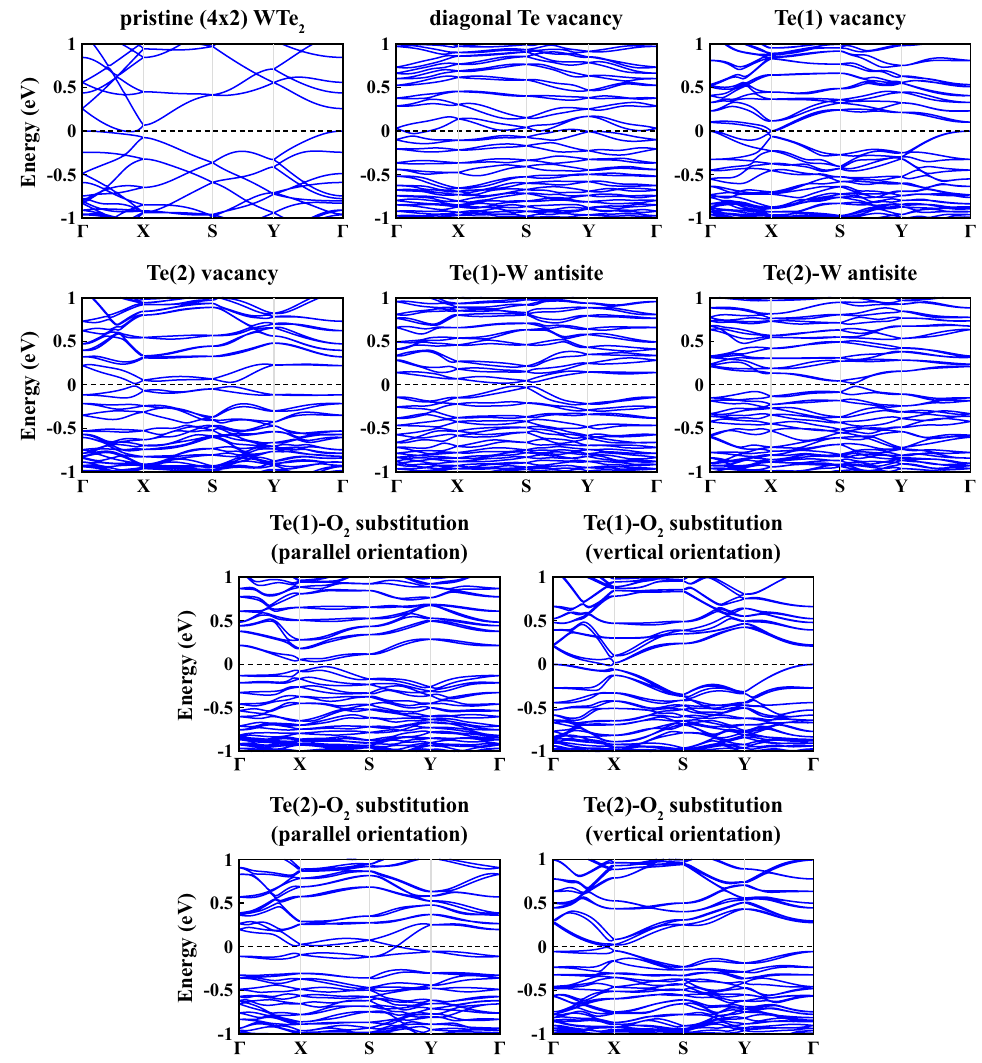
Figure 7. Electronic energy band structures, E n ( k ) , of defective 1 T ′ WTe 2 monolayer calculated within PBE+SOC along major symmetry directions of the 2D Brillouin zone. Zero of energy is set at the Fermi level shown by black-dashed